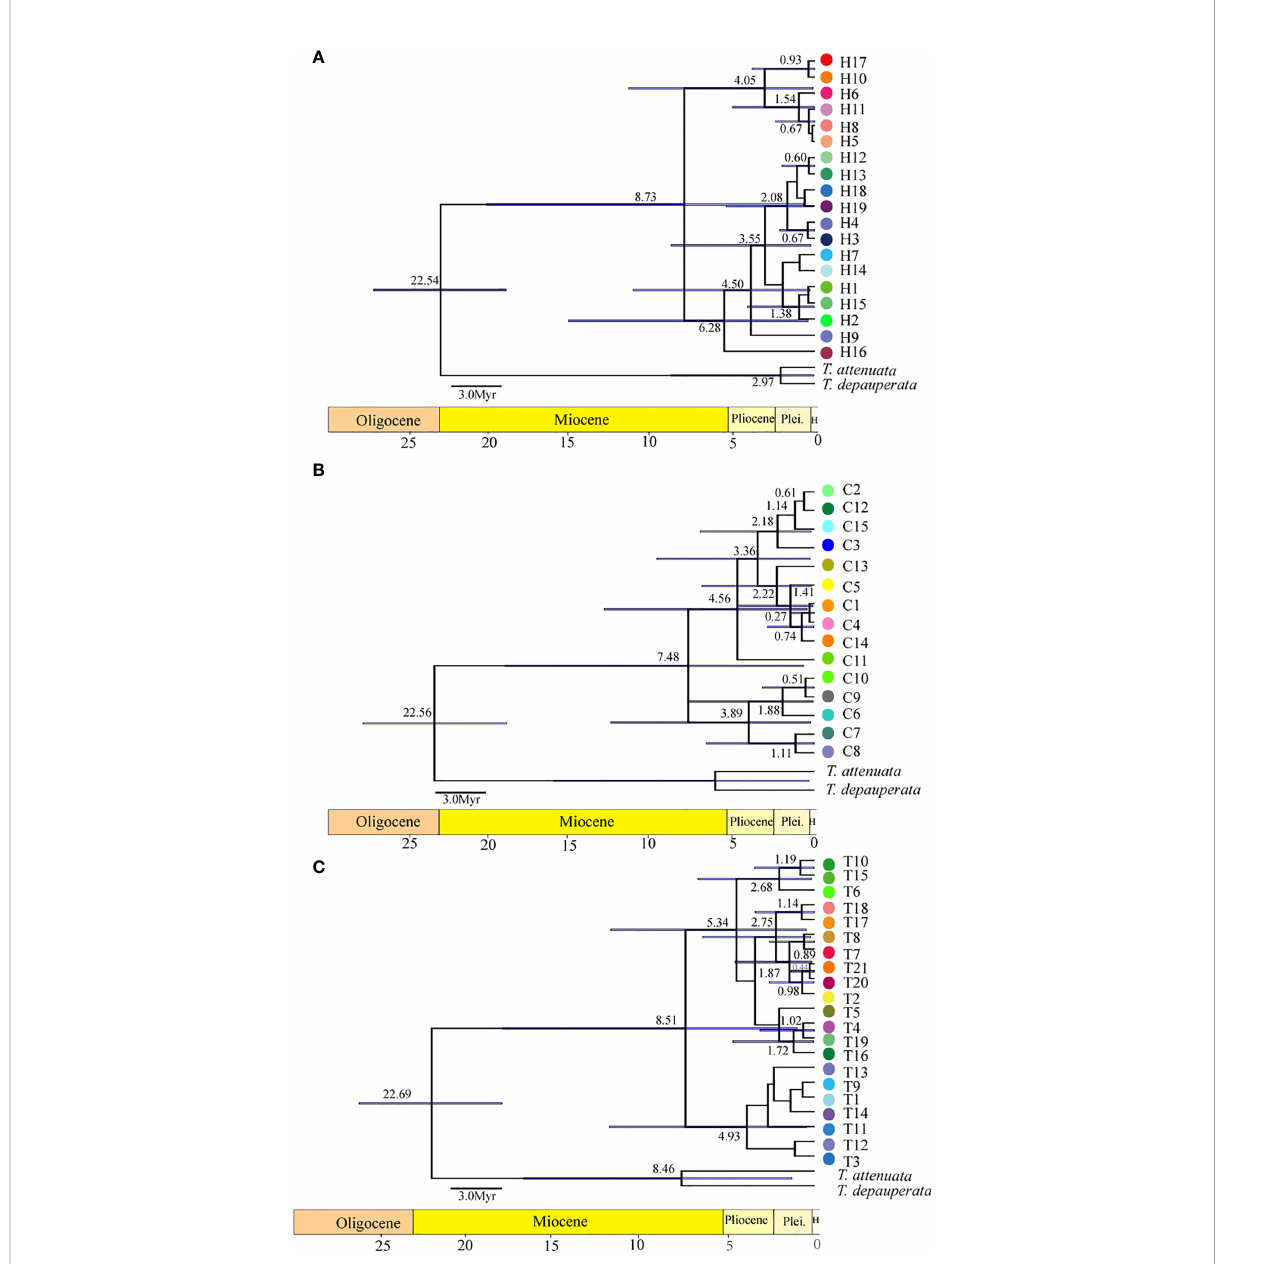
FIGURE 4 The chronogram of H. lichiangensis haplotypes reconstructed by BEAST. The BEAST trees are inferred by using a second calibration based on (A) cpDNA, (B) CAMX , (C) ITS data matrices. Tip labels refer to the haplotype number as shown in Figure 1 (A – C) . The bar on the node depicts the 95% HPD (highest posterior density interval) in age estimation. The bar under each chronogram depicts the geological timescale. Pleis, Pleistocene; H,